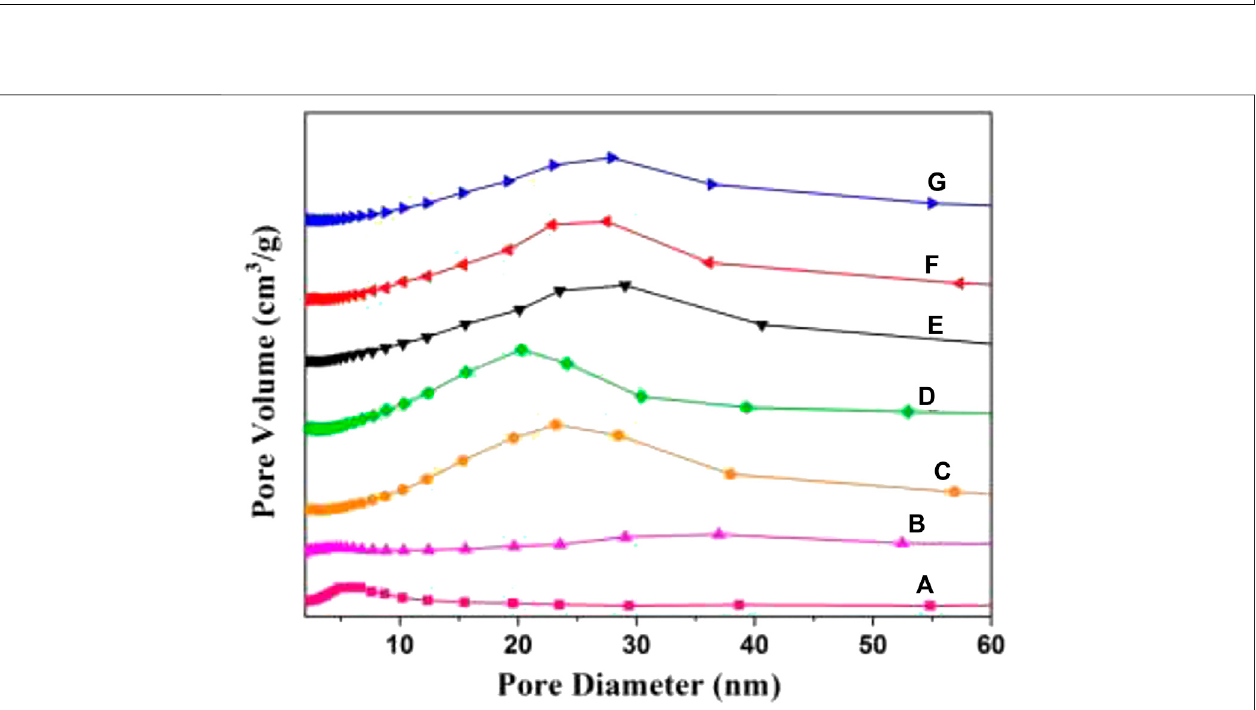
FIGURE 7 | Mesoporous distribution curves of 3DOM catalysts. (A) ZrTiO 4 ; (B) W 1 MnO δ /ZrTiO 4 ; (C) W 1 CeO δ /ZrTiO 4 ; (D) W 1 CeMnO δ /TiO 2 ; (E) W 0.5 CeMnO δ / ZrTiO 4 ; (F) W 1 CeMnO δ /ZrTiO 4 ; (G) W 2 CeMnO δ /ZrTiO 4 .